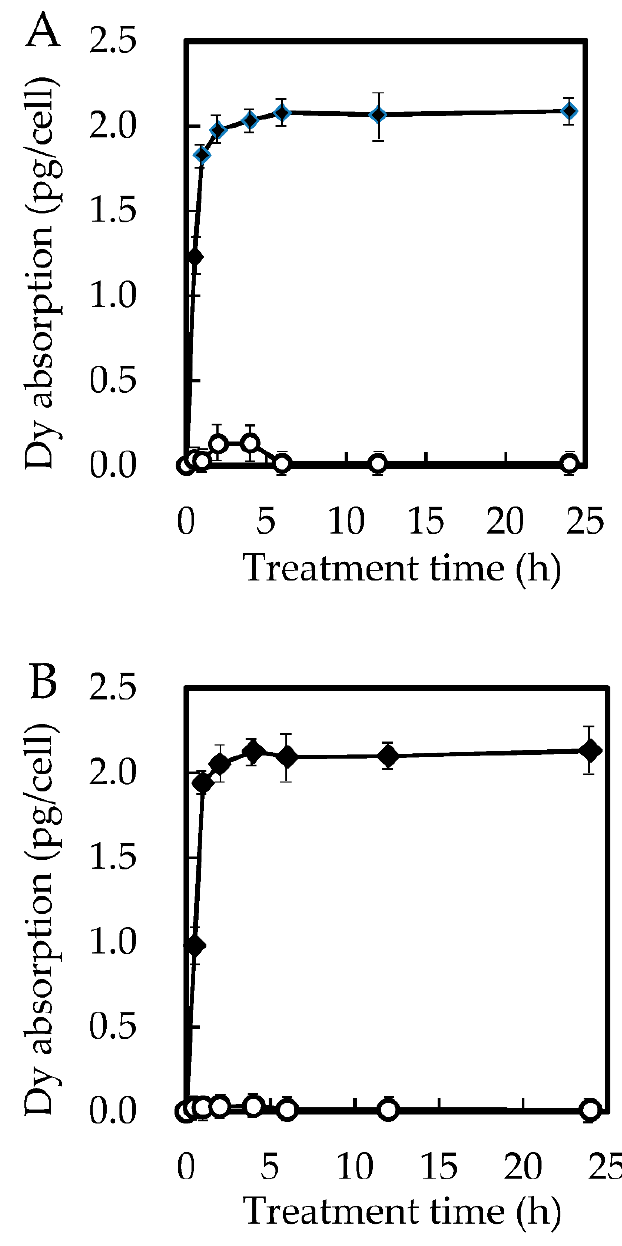
Figure 5. Dy content of protoplasts and solubilized cell wall fraction in the Alt-OF2 ( A ) and Alt-OF5 ( B ). Yeast cells were treated with 0.1 g/L of Dy acetate for 1 h, collected, and then digested with Zymolyase 100-T for 1 h. Closed diamonds and open circles represent the Dy concentration in protoplasts and the solubilizing cell wall fraction, respectively.